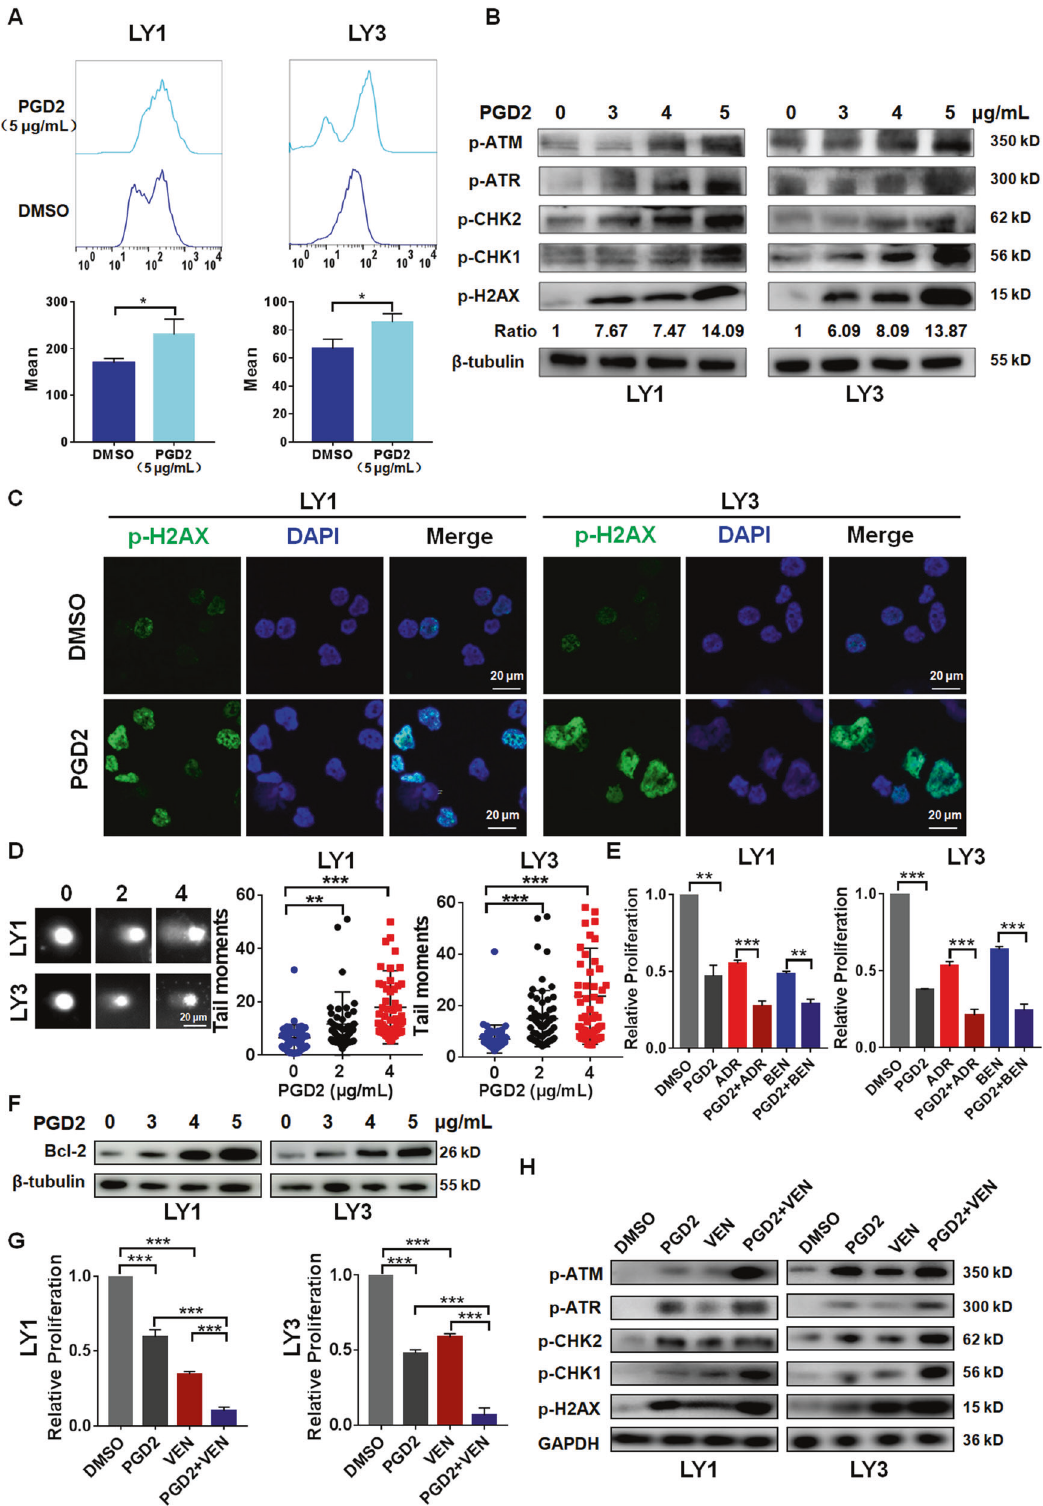
Fig. 4 High-concentration PGD2 induced ROS-mediated DNA damage and enhanced drug cytotoxicity in DLBCL cells. A High- concentration PGD2 increased the mean fl uorescence intensity of DLBCL cells loaded with DCFH-DA probe, indicating the intracellular accumulation of ROS. B High-concentration PGD2 promoted the phosphorylation of key regulators in DNA damage pathway. C Immuno fl uorescent images indicated that high-concentration PGD2 increased the expression of p-H2AX in DLBCL cells. Bar = 20 μ m. D Representative images and quanti fi cation of the tail in comet assay. Bar = 20 μ m. E High-concentration PGD2 enhanced the cytotoxicity of Adriamycin (ADR) and Bendamustine (BEN) in LY1 and LY3 cells. F High-concentration PGD2 increased the expression of Bcl-2 in DLBCL cells. G , H High-concentration PGD2 was observed to enhance the cytotoxicity of venetoclax in DLBCL cells. Cells were treated with drugs for 48 h. Data are shown as the mean ± SD. * p < 0.05; ** p < 0.01; *** p < 0.001. Cell Death Discovery (2023)